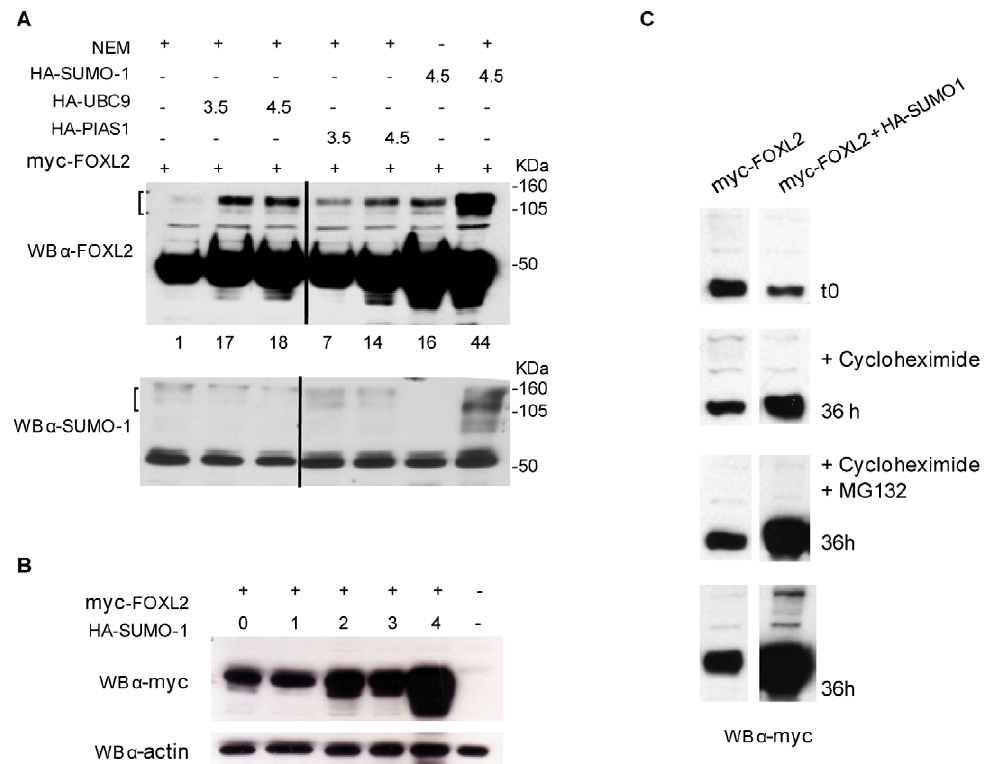
Figure 2. FOXL2 stability is increased by SUMO-1 and is not dependent on proteasome-mediated degradation. A. Sumoylation regulates FOXL2 stability: COS-7 cells were co-transfected with pCRUZ-myc-FOXL2 (0.5 m g) and increasing amounts of pCRUZ-HA-UBC9 or pCRUZ- HA-PIAS1(3.5–4.5 m g) or pCRUZ-HA-SUMO-1 (4.5 m g). Lysates treated with and without NEM were analysed by immunoblotting with anti-FOXL2 antibody. The bracket shows slower migrating bands of about 105–160 kDa. Densitometric analysis was performed on sumoylated band using Image J software and is reported compared to that in lane 1. B. FOXL2 stabilization is mediated by SUMO-1 in a dose-dependent manner: COS7 were transfected with 500 ng of pCRUZ-myc-FOXL2 and increasing amounts of pCRUZ-HA-SUMO-1 (0, 1, 2, 3, 4 m g). Immunoblotting against myc shows that FOXL2 increases with the augmentation of SUMO-1. In the lower panel anti-actin is used as loading control. C. FOXL2 stability is not dependent on ubiquitination and proteasome-mediated degradation: COS7 cells were transfected with pCRUZ-HA-FOXL2 alone and with pCRUZ-HA-SUMO-1 in quadruplicate. After 12 h of transfection, cells were lysed (t0) or treated with cycloheximide (inhibitor of protein biosynthesis), cycloheximide and MG132 (proteasome-inhibitor) or neither. After 36 h cells were lysed and 50 ug of protein were blotted and hybridization performed with anti-myc antibody.